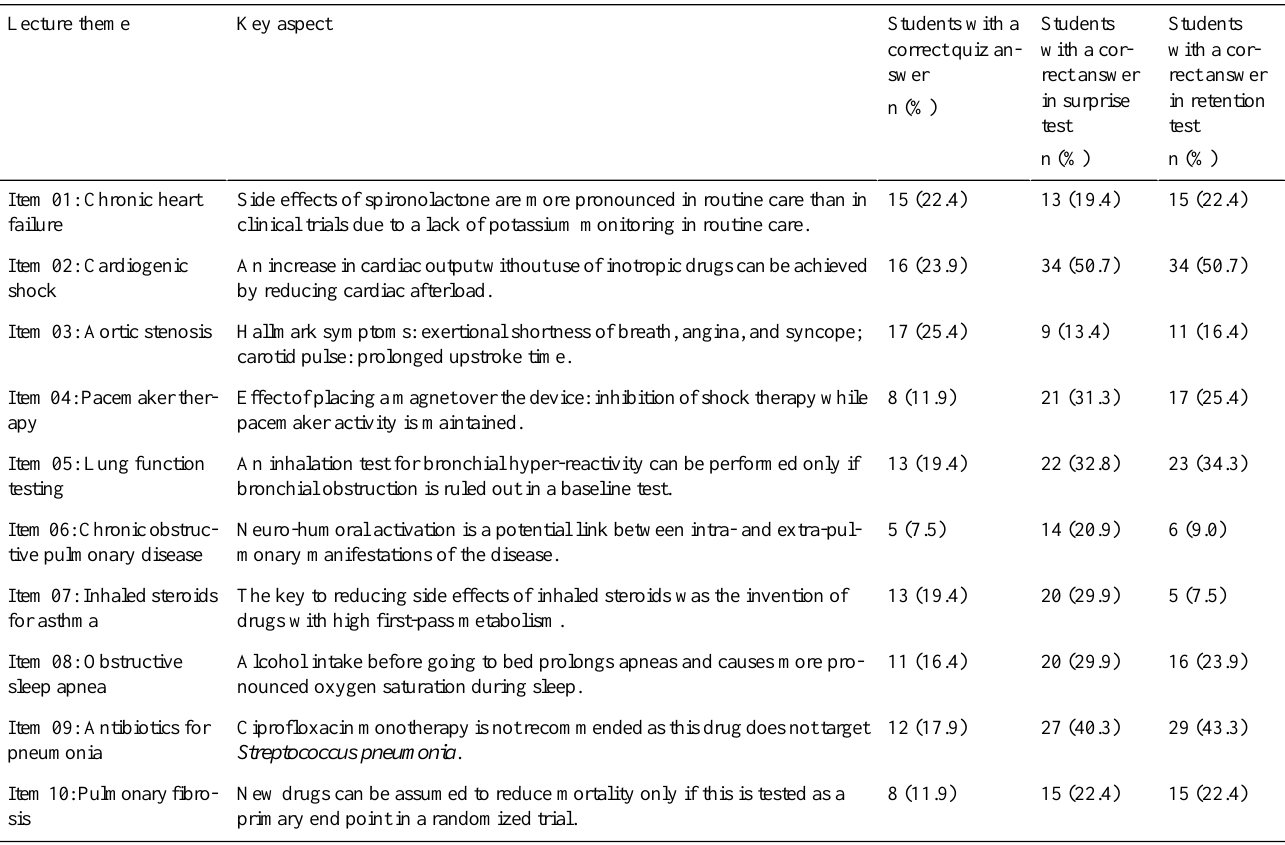
Table 1. Key aspects covered in podcast lectures and student performance in quizzes as well as in the surprise and retention tests.